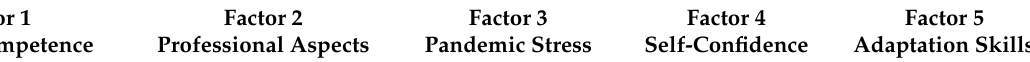
Table 2. Factorial weights and factors defined by the EFA.